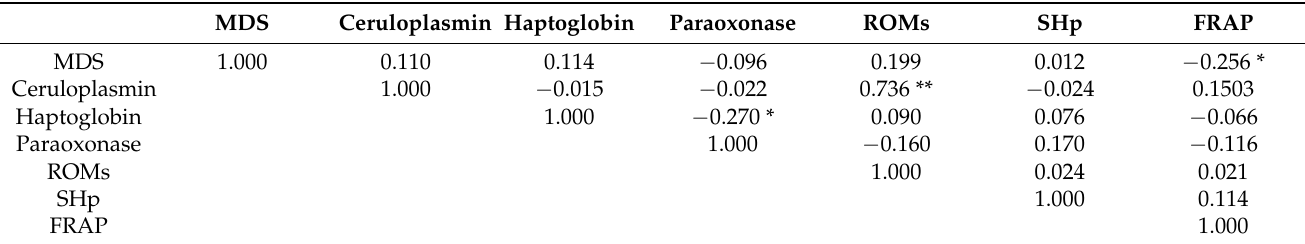
Table 3. Correlation (r) between Mediterranean Score (MDS) and markers of